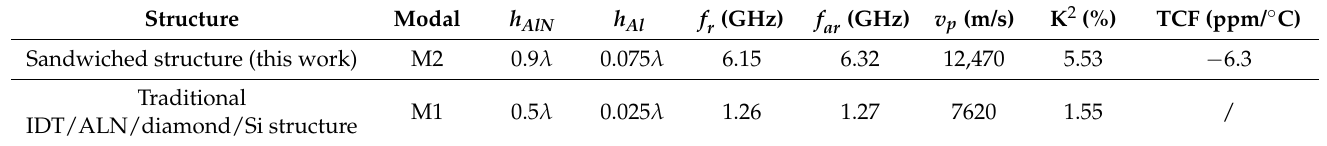
Table 4. Optimized parameters of sandwiched multilayer SAW structure